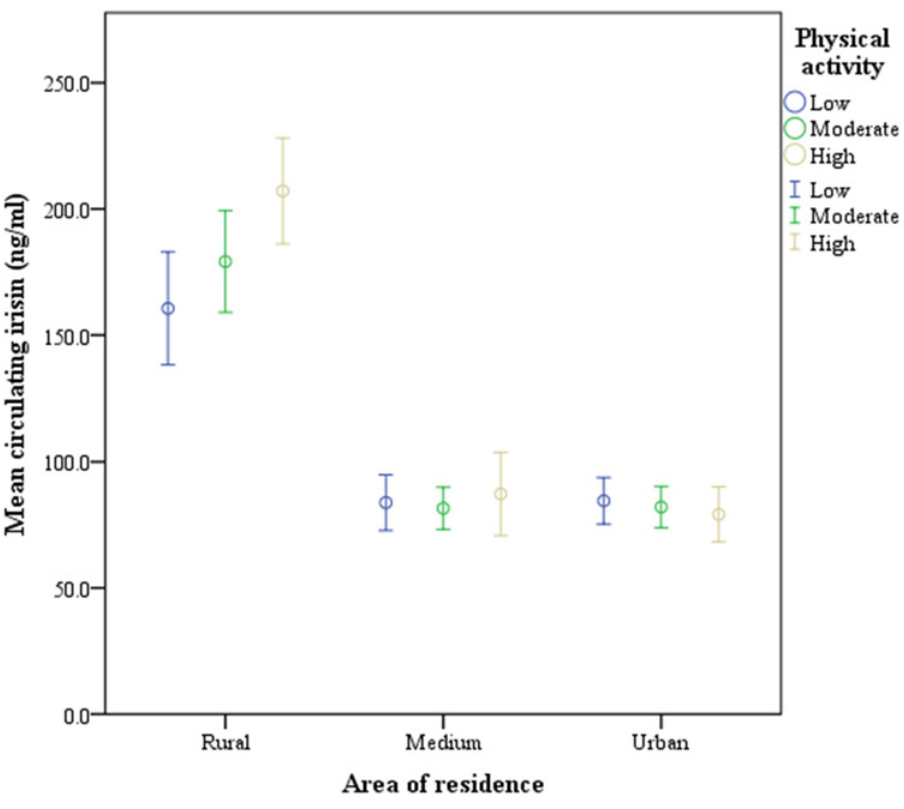
Fig 3. Circulating irisin levels according to the area of residence based on their self-reported leisure time physical activity categories (n = 428) (only significant differences are shown).